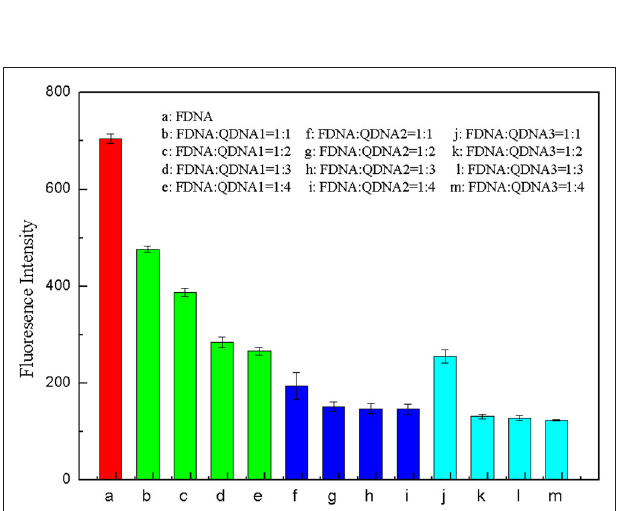
FIGURE 5 | Optimization of concentration ratio between FDNA and QDNA. (a) FDNA, (b ∼ e) FDNA: QDNA1 = 1:1 ∼ 1:4, (f ∼ i) FDNA: QDNA2 = 1:1 ∼ 1:4, (g ∼ m) FDNA: QDNA3 = 1:1 ∼ 1:4. The concentration of FDNA was 0.05 µ M, and QDNAs were 0.05, 0.1, 0.15, 0.2 µ M, respectively.